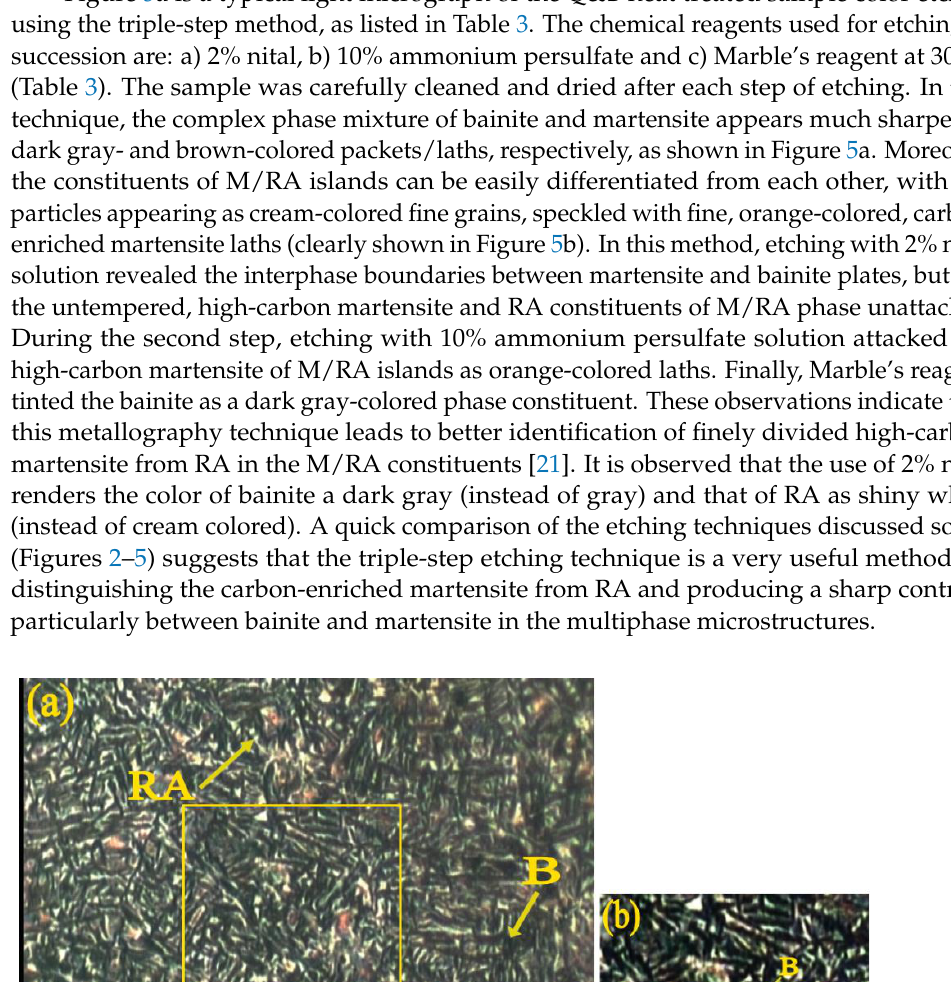
Figure 4. ( a ) Double-step II etching method (10% ammonium persulfate solution + warm Marble’s reagent at 30 °C). ( b ) Enlarged image view of the square shown in ( a ). The abbreviations B, M and M/RA represent bainite, martensite and martensite/retained austenite phase constituents, respec- tively.